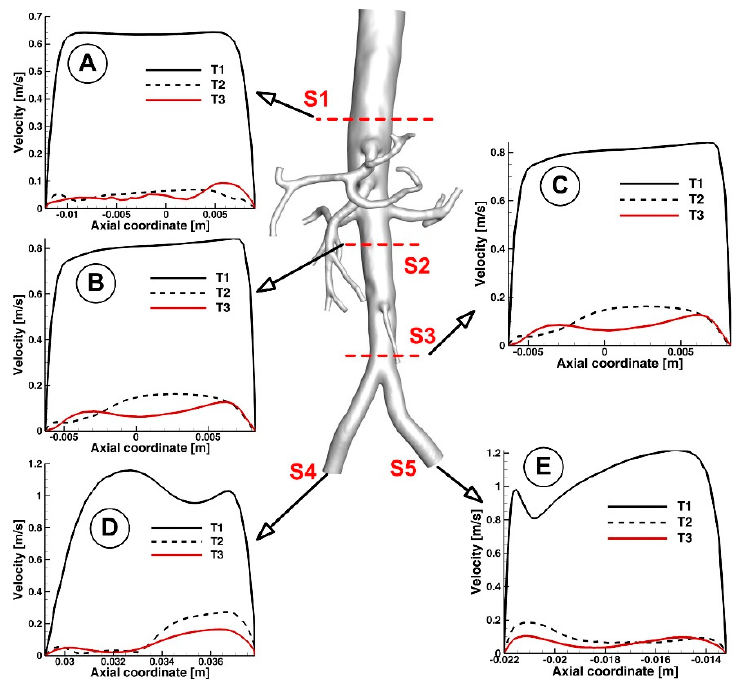
Figure 13. Cross-sectional flow pattern evolution in a different section of the investigated aorta. Velocity profile representation along the diameter associated to the cross-sections ( A ) S1, ( B ) S2, ( C ) S3, ( D ) S4 and ( E ) S5.